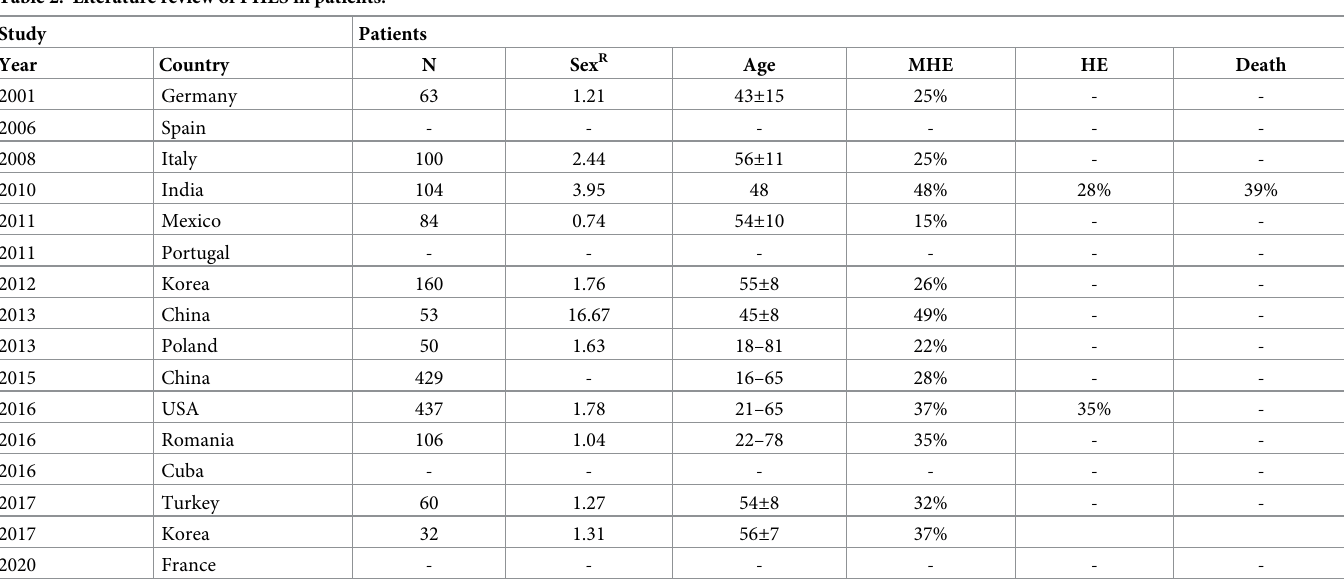
Table 2. Literature review of PHES in